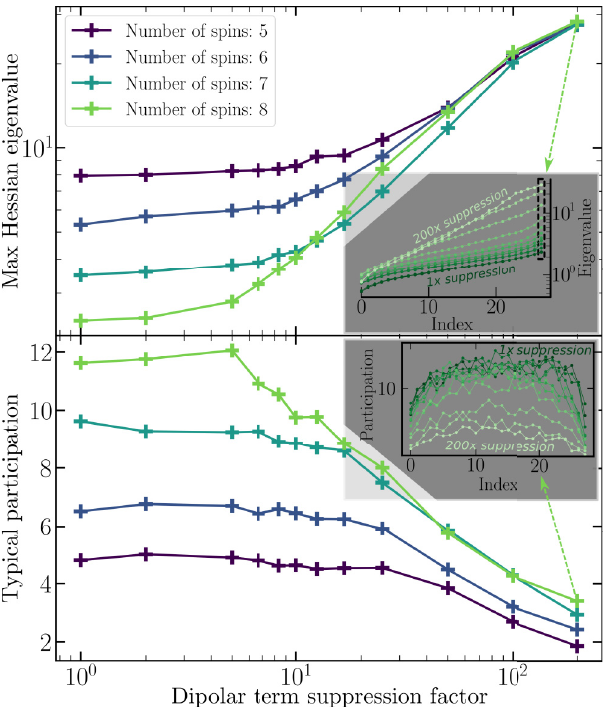
FIG. 7. Eigenvalue and eigenvector participation data for Hes- sians of the Hamiltonian learning problem for small spin clusters in ubiquitin. [Data are taken as the set of (cid:7) Z i ( t ) Z j ( 0 ) (cid:6) and ( t ) X ( 0 ) (cid:6) correlators using a set of equally spaced times (cid:7) X i j between t = 0 and t = 5 ms in the absence of sampling noise, implying that units of the Hessian eigenvalues are arbitrary.] Top: typical (geometric mean) largest Hessian eigenvalue for different system sizes as the dipolar term is suppressed. Inset shows the typical Hessian spectrum for each suppression factor over clus- ters of eight spins—the light green line in the main plot is taken from the indicated cut through the inset. Bottom: typical (geo- metric mean) eigenvector participation [Eq. (55)] for the same dataset. Inset shows the participation across the entire Hessian spectrum for clusters of eight spins; each datapoint in the light green line in the main plot corresponds to a geometric mean over a single line in the